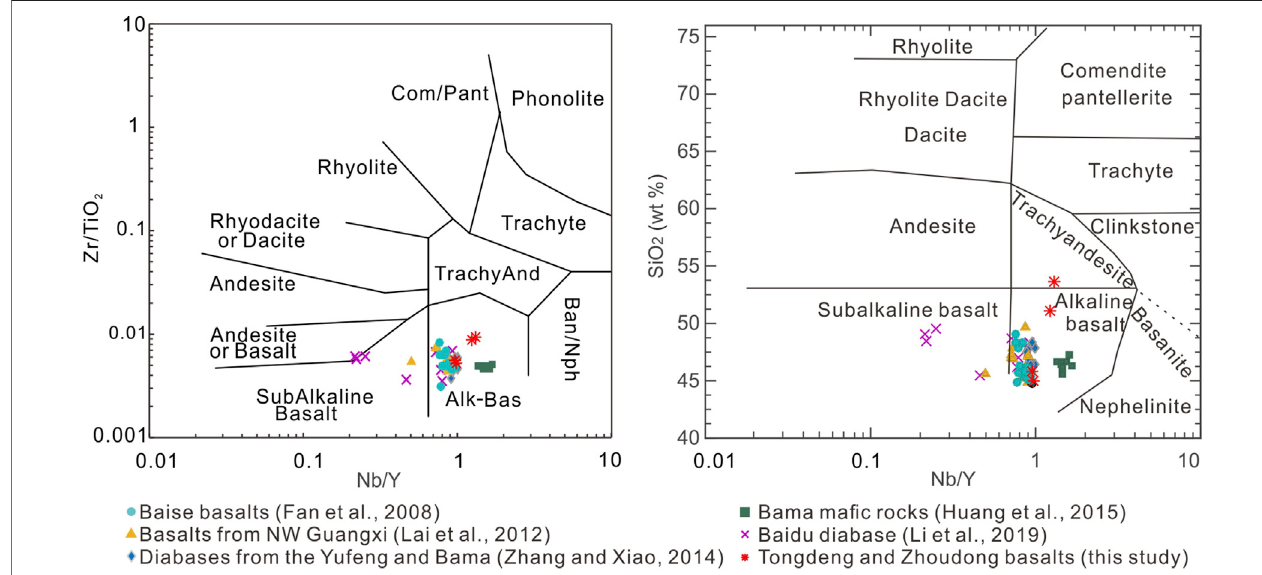
FIGURE 5 | (A) Zr/TiO 2 -Nb/Y and (B) SiO 2 -Nb/Y (Winchester and Floyd, 1977) discrimination diagrams for the ma fi c rocks from western Guangxi. Published data of other Late Permian ma fi c magmatic rocks in western Guangxi are also shown for comparison (Baise basalts, Fan et al., 2008; basalts from NW Guangxi, Lai et al., 2012; diabases from the Yufeng, and Bama, Zhang and Xiao, 2014; Bama ma fi c rocks, Huang et al., 2015; Baidu diabase, Li et al., 2019).